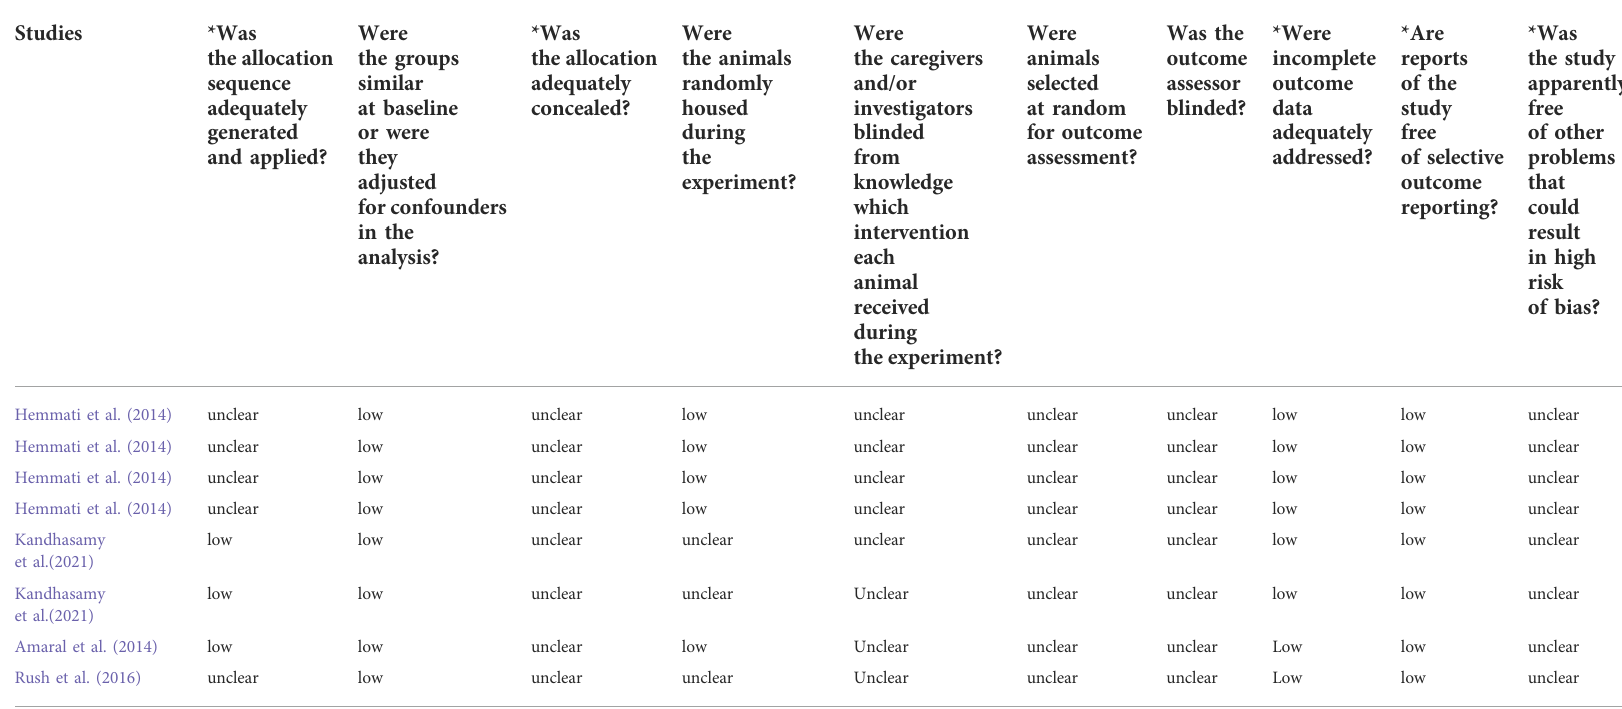
*Items in agreement with the items in the Cochrane Risk of Bias